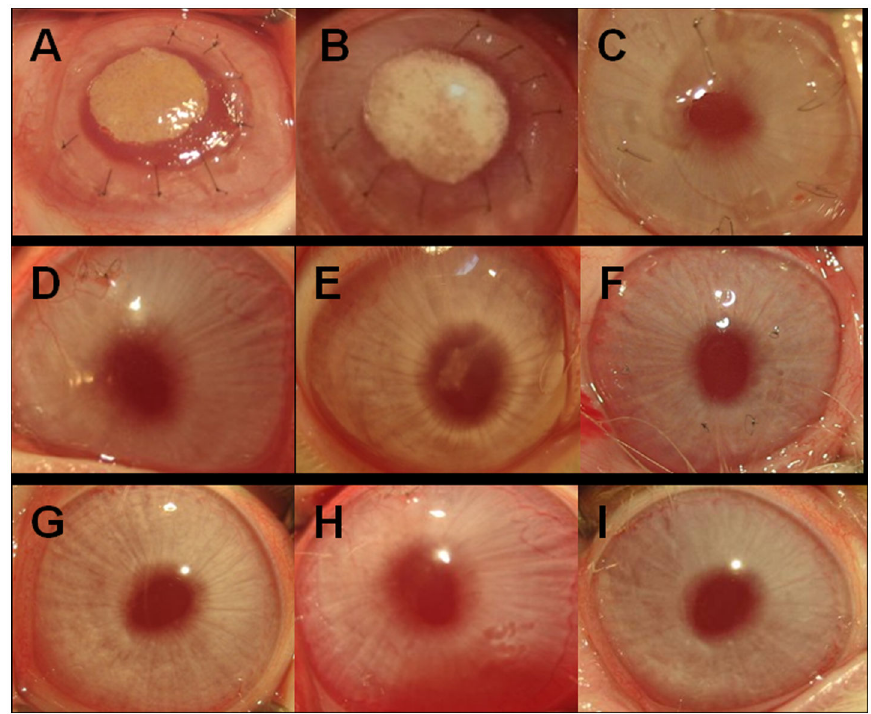
Figure 3. Gross view of the grafts in each group at 12 weeks and 24 weeks post-surgery. A, B, C: 0 weeks; D, E, F: 12 weeks; G, H, I: 24 weeks. A, D, G: Autologous rASCs+PLGA; B, E, H: PLGA alone; C, F, I: Only defect. At 12 weeks, the scaffold was mostly degraded and the corneas became nearly transparent in the group with implantation of the rASCs-PLGA construct while a partial scaffold still resides in the group with PLGA alone implantation. These two groups became transparent and showed no significant difference compared with the defect group and the normal cornea at 24 weeks. No inflammation or vascularization was found in all groups at 24 weeks after